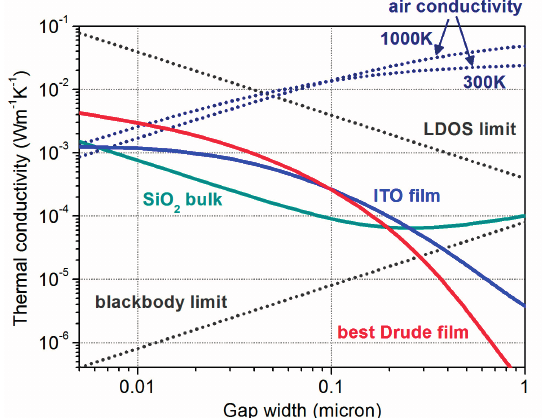
Figure 9. Comparison of the thermal conductivity across a narrow gap via thermal radiation through vacuum and via heat conduction through air as a function of the gap width. The solid lines correspond to the conductivity via near field radiation between 2 nm-thin ITO films (blue), bulk SiO 2 (teal), and 2 nm-thin plasmonic films with optimized Drude model parameters (red). The dotted gray lines denote the LDOS and the blackbody radiation limits. The dotted dark blue lines correspond to the heat conductivity through air slab for air temperatures of 300 K and 1000 K calculated via Equation (7). The bulk thermal 300 K = 0.026 Wm − 1 K − 1 conductivity and viscosity values are taken from the literature: K B